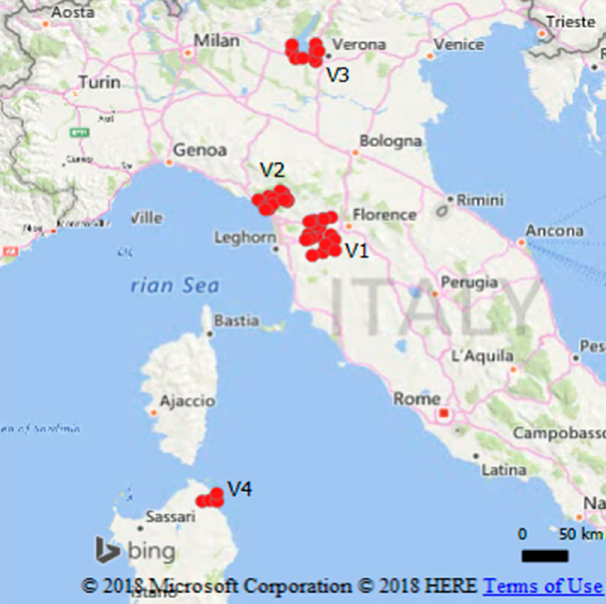
Figure 15. Similarity comparison between four visitors distributed over a wide territory. The red spots represent the area covered by the movements of each visitor. The highest similarity is between V1 and V2, located in geographically closer areas. However, V1 is more similar than V2 towards V3 and V4: V1 covers a larger territory along Arno river near bigger cities such as Florence, Leghorn and Pisa, whereas V2 is located in a very touristic coastal area made of small towns and more distant from cities, centers of longer-distance motion